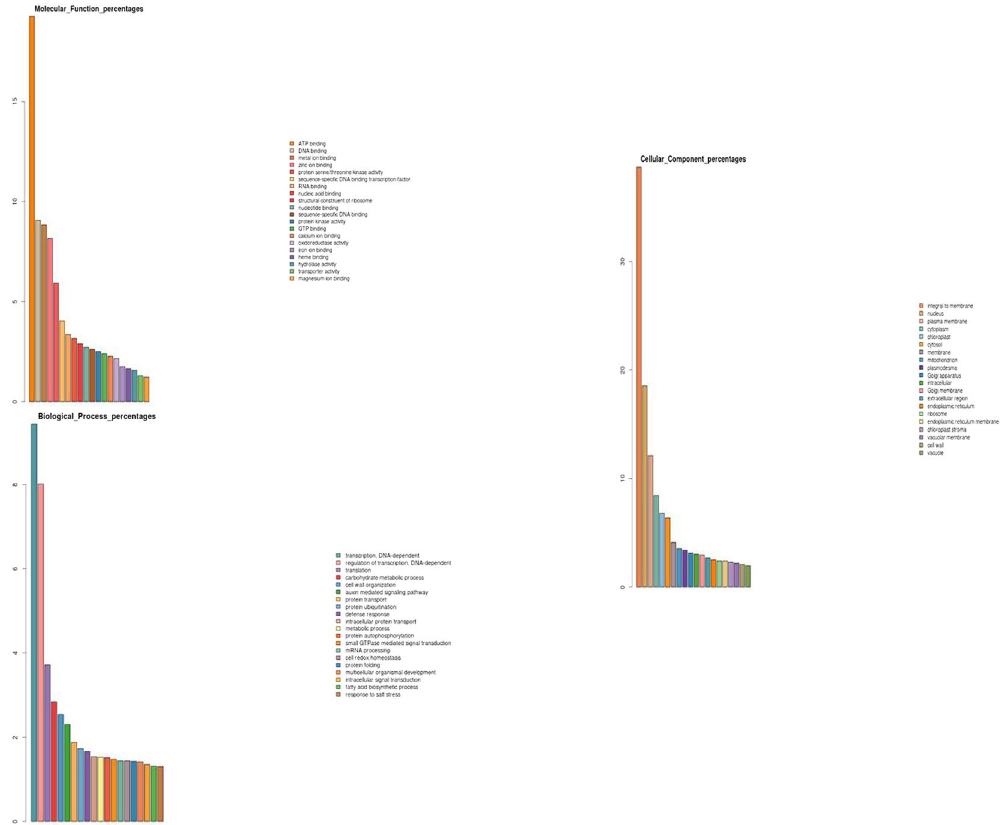
Figure 2. Gene ontology classification of the heat stress transcriptome. ( A ) Molecular function ( B ) Cellular components ( C ) Biological